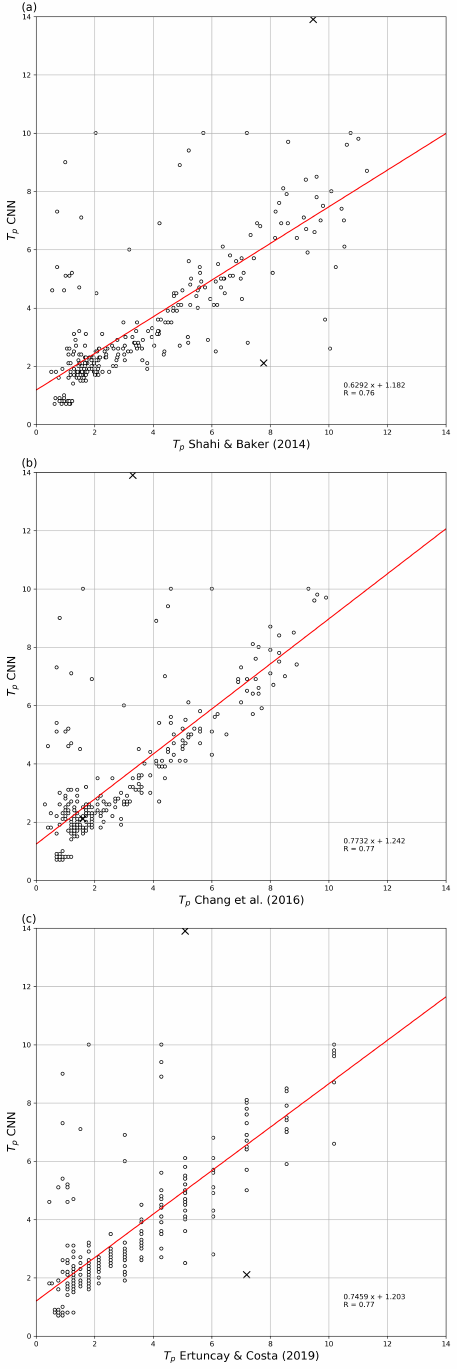
Figure 4. Comparison between pulse periods found by ( a ) Shahi and Baker [17], ( b ) Chang et al. [22], and ( c ) Ertuncay and Costa [23]. Red lines are the regression lines, and their formulate with R value are given on lower left. Outliers are plotted with x , and other impulsive signals are plotted with